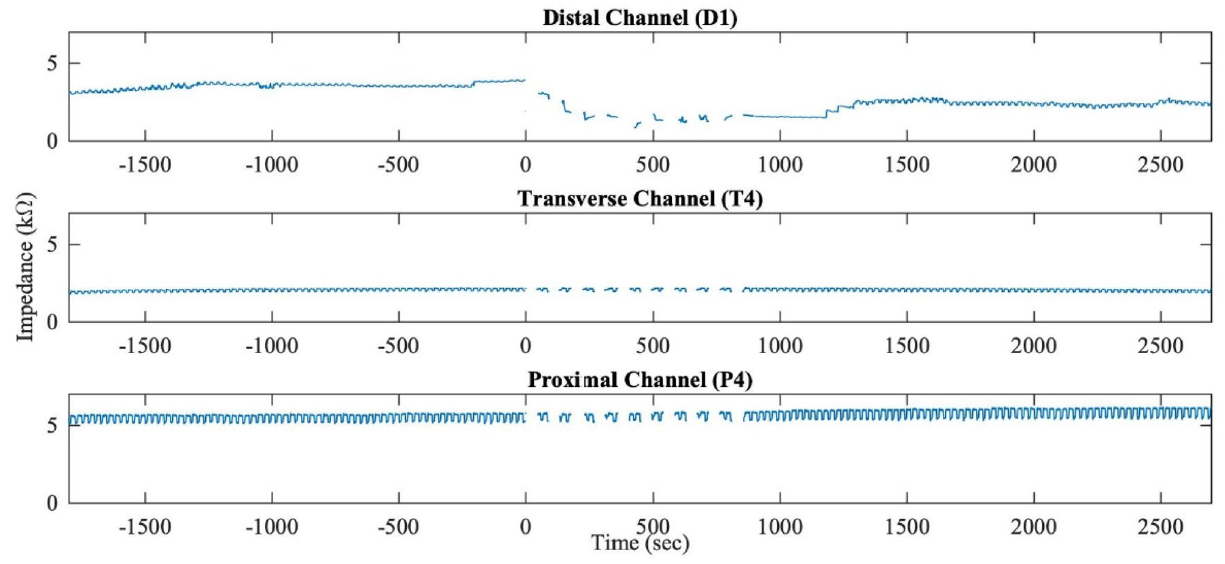
Figure 4. Example of different bio-impedance responses in time domain in proximal (P4), transverse (T4), and distal colon (D1). Stimulation starts at 0 s, and end at 900 s. Little or no DC changes in proximal and transverse colon while large impedance drop in distal colon during the stimulation, and gradually raise after the stimulation. n Stimulation (in %